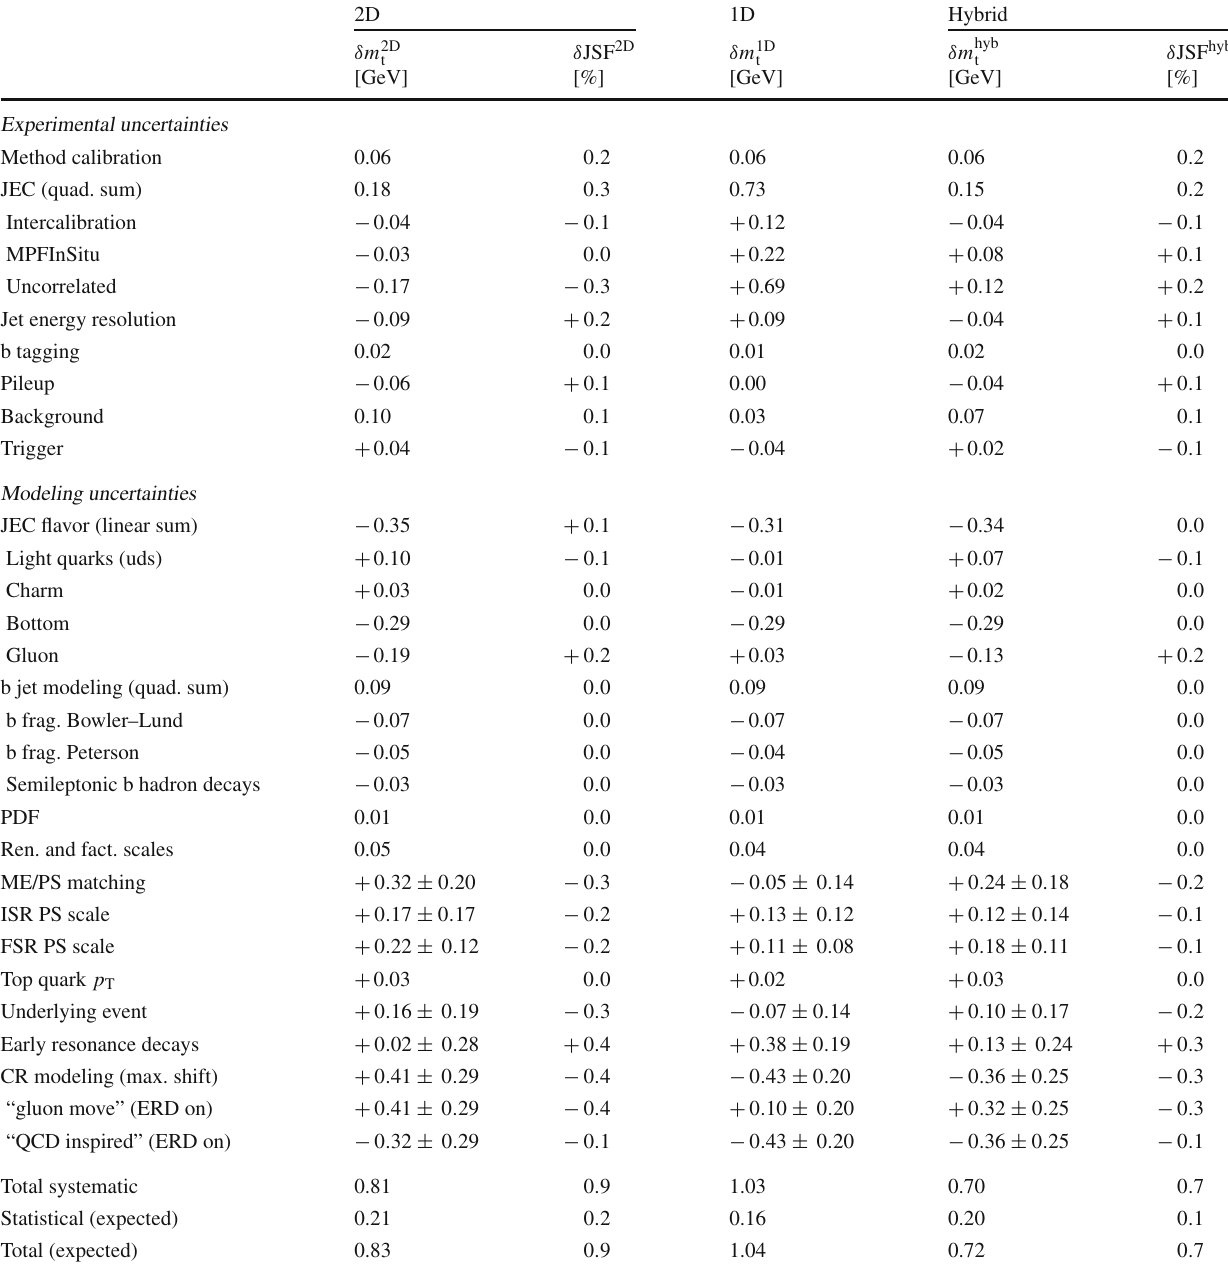
Table 1 List of systematic uncertainties for the all-jets channel. The signs of the shifts ( δ x = x variation − x nominal ) correspond to the + 1 stan- dard deviation variation of the systematic uncertainty source. For linear